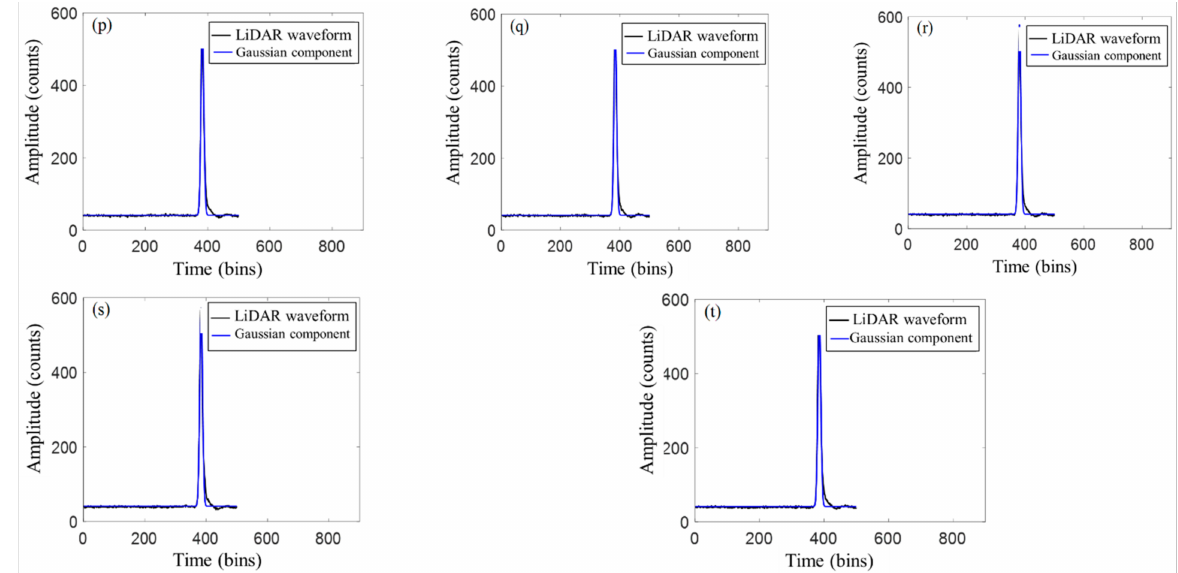
Figure A2. ( a – t ) LiDAR waveform data and decomposed waveforms of ocean LiDAR waveforms in Antarctica. The abscissa is the sampling time point of the LiDAR waveform and the ordinate is the amplitude coordinate of the